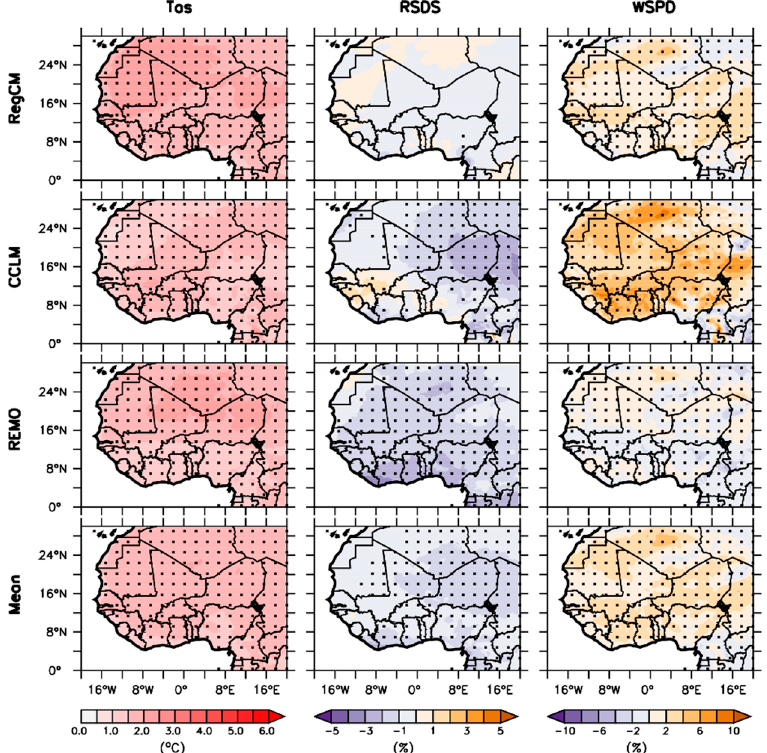
Figure 8. Projected changes in the annual average of solar irradiance (RSDS), ambient air temperature (Tas), and surface wind speed (WSPD) over West Africa for the near future (2021–2050) and under the RCP8.5 scenario. Statistically significant areas are indicated with black dots.